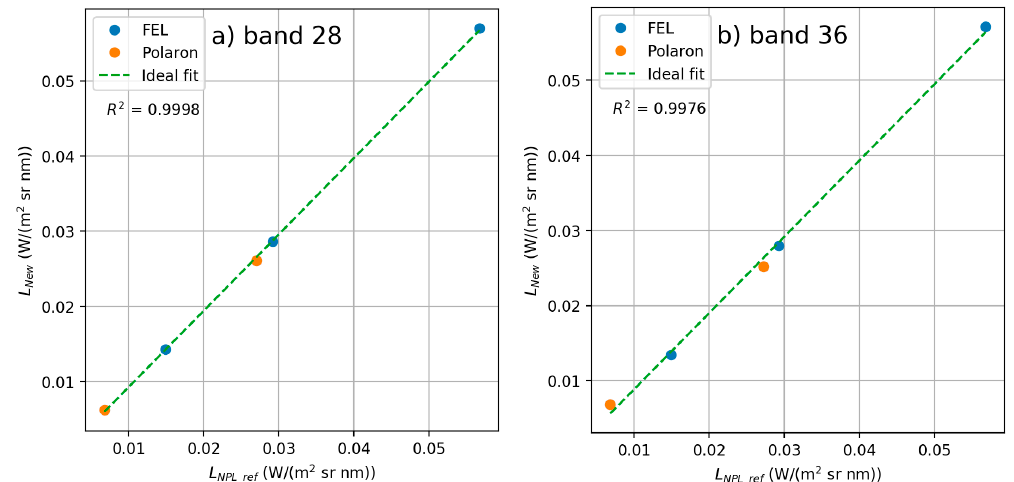
Figure 15. Linearity plots for ( a ) band 28 ( (cid:2019) (cid:2868) = 761.2 nm) and ( b ) band 36 ( (cid:2019) (cid:2868) = 885.9 nm).